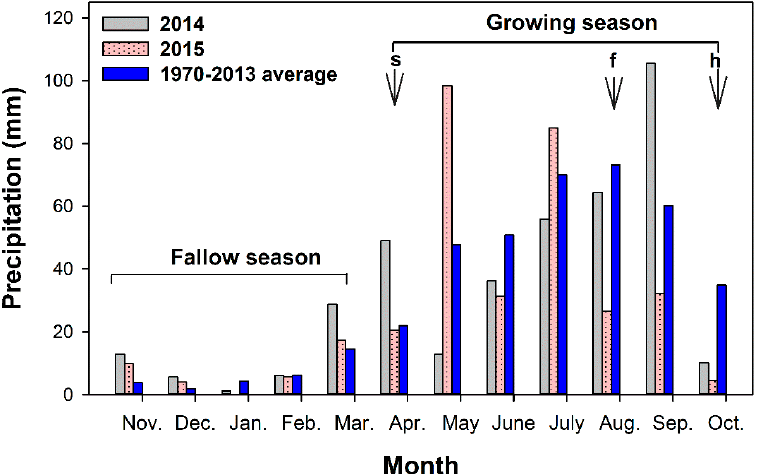
Figure 2. Average monthly precipitation in 2014 and 2015, and the long-term (1970–2013) monthly precipitation means at the Rainfed Agricultural Experiment Station of Gansu Agricultural University, Dingxi City (35 ◦ 28 (cid:48) N, 104 ◦ 44 (cid:48) E), Gansu Province, China. The three major growth stages of maize, sowing (s), flowering (f), and harvest (h) are indicated on the